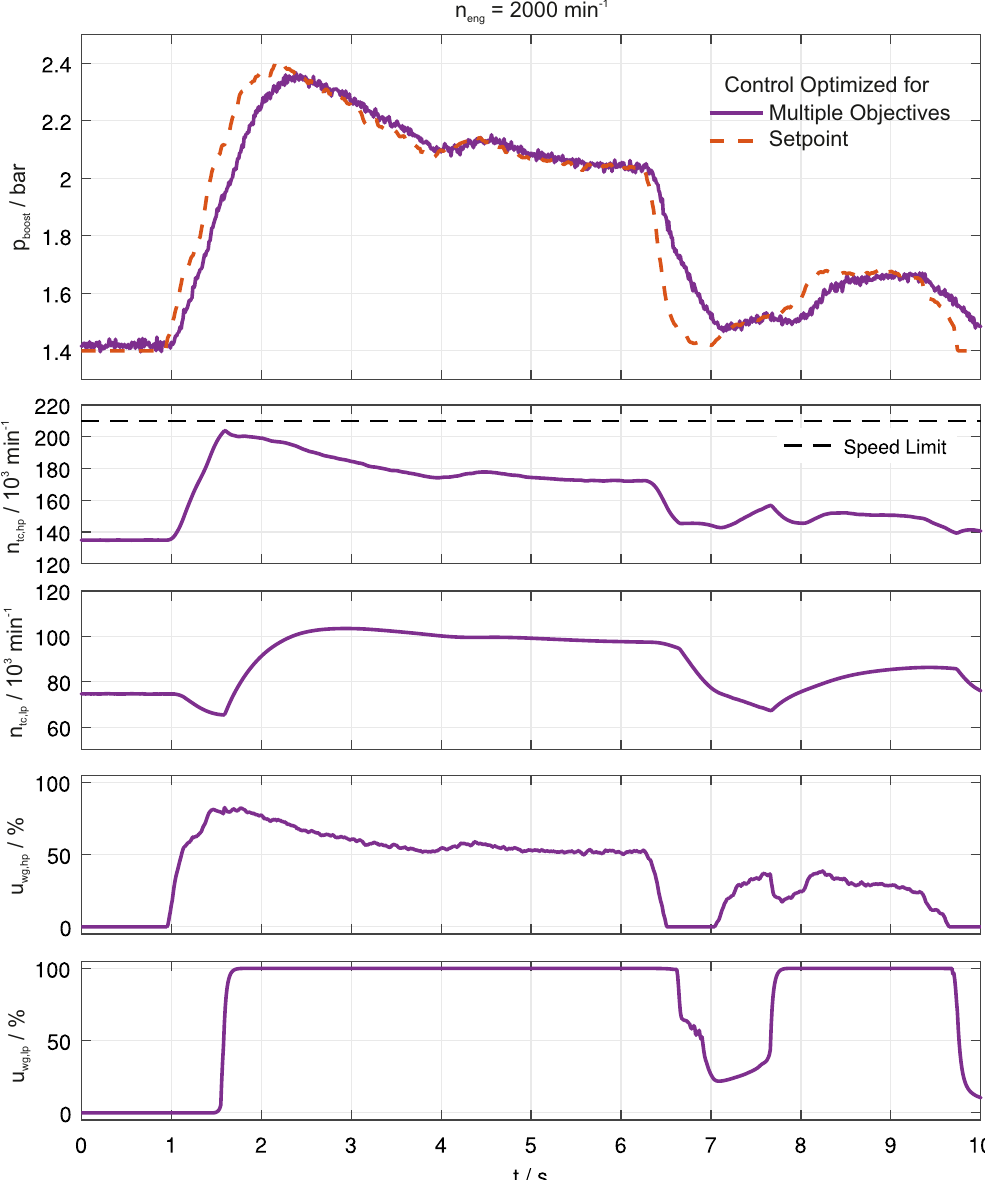
Figure 7. Closed-loop simulations: multi-objective control strategy for a real setpoint